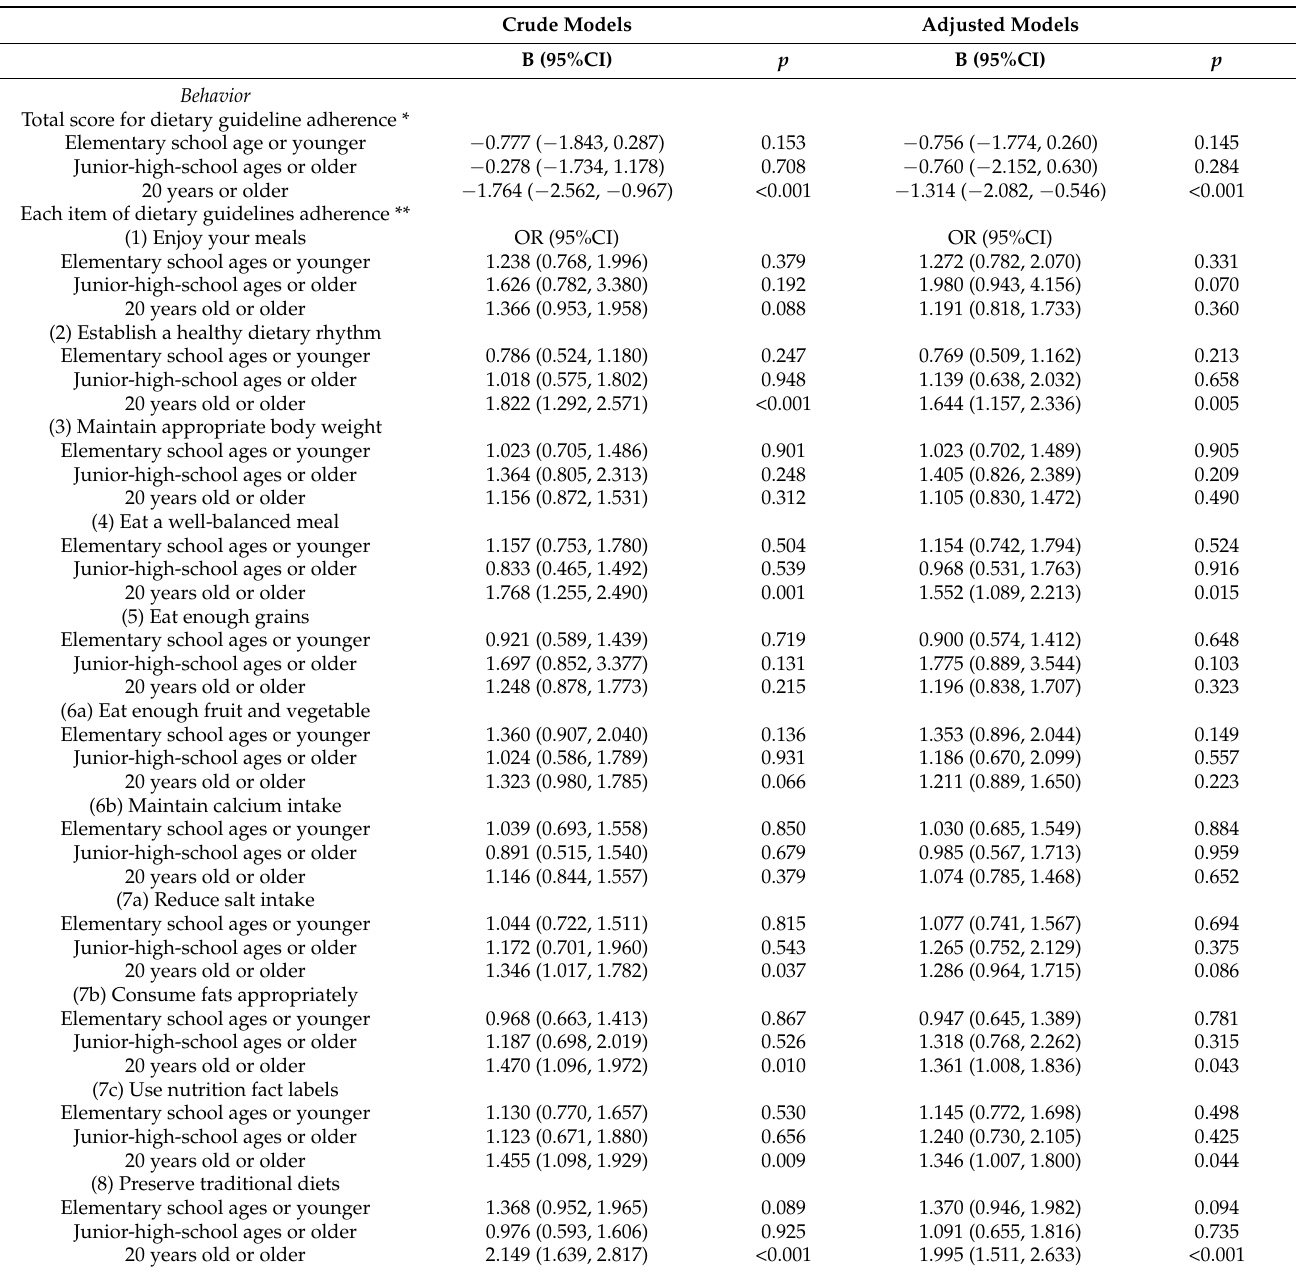
Table 4. Life stage at which food production experience occurred and behavior, attitude, and knowledge of dietary recommendations in their 50s and 60s. (N =